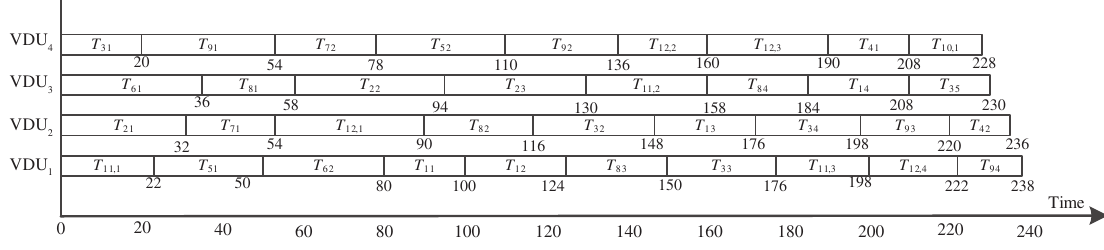
Figure 5: Gantt Chart of Static Allocation.